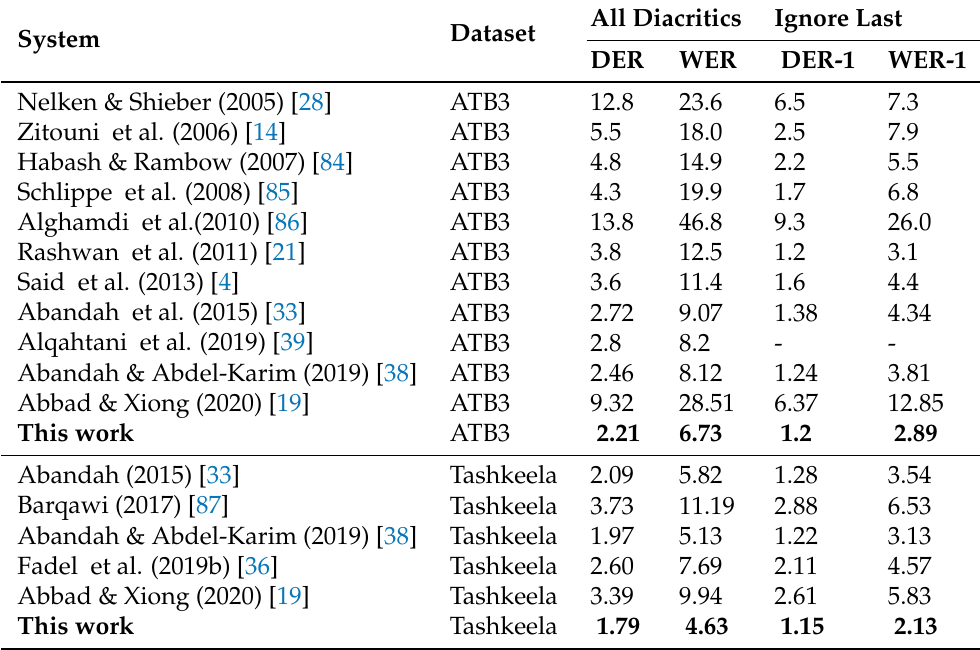
Table 5. Diacritization results of previous systems and our